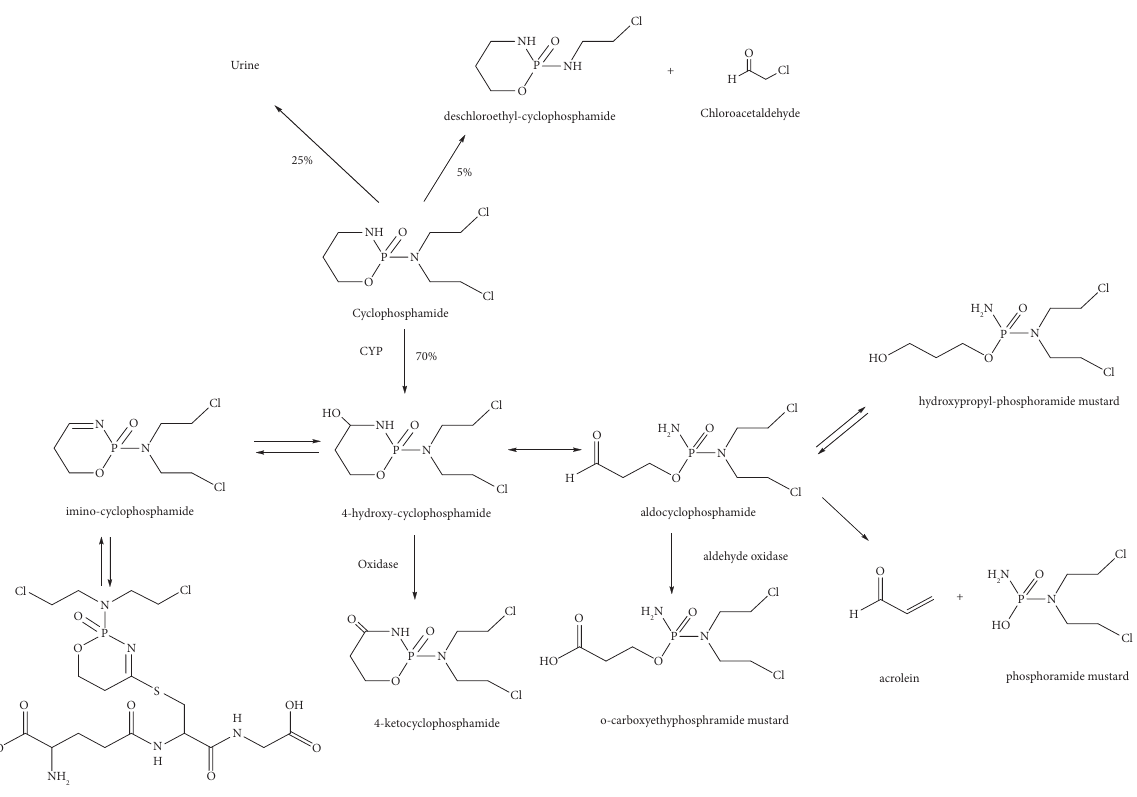
Figure 1: Major metabolism and disposition pathways of